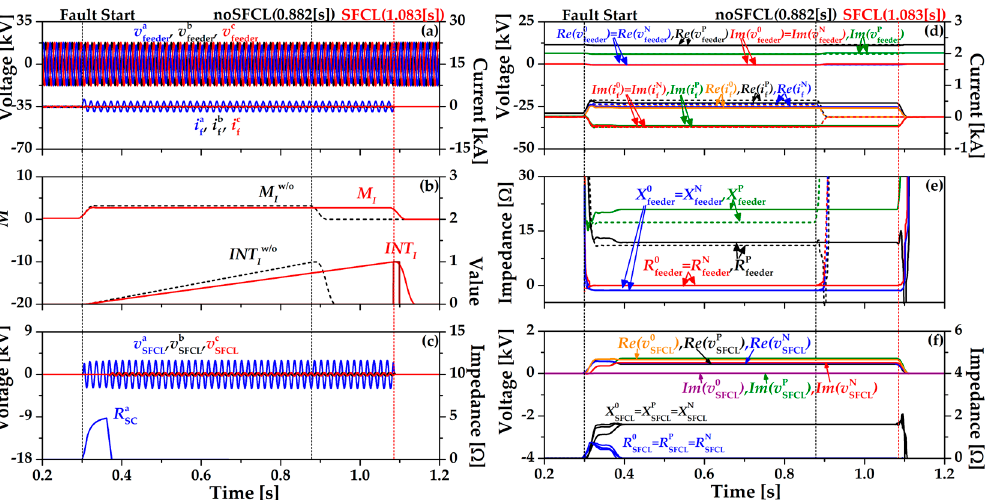
Figure 4. Waveforms and signals of OCR using M I in SLG. ( a ) Three phase feeder voltage ( v feeder ), current ( i f ). ( b ) Index of CB ( M I ) and signal of OCR ( INT I ). ( c ) Three phase SFCL voltage ( v SFCL ), HTSC element ( R a SC ). ( d ) Sequence feeder voltages ( v 0 feeder , v P feeder , v N feeder ), sequence feeder currents ( i 0 f , i P f , i N f ). ( e ) Sequence feeder impedances ( R 0 feeder , R Pfeeder , R Nfeeder , X 0 feeder , X Pfeeder , X Nfeeder ). ( f ) Sequence SFCL voltages ( v 0 SFCL , v PSFCL , v NSFCL ) and sequence SFCL impedances ( R 0 SFCL , R PSFCL , R NSFCL , X 0 SFCL , X PSFCL , X NSFCL ).